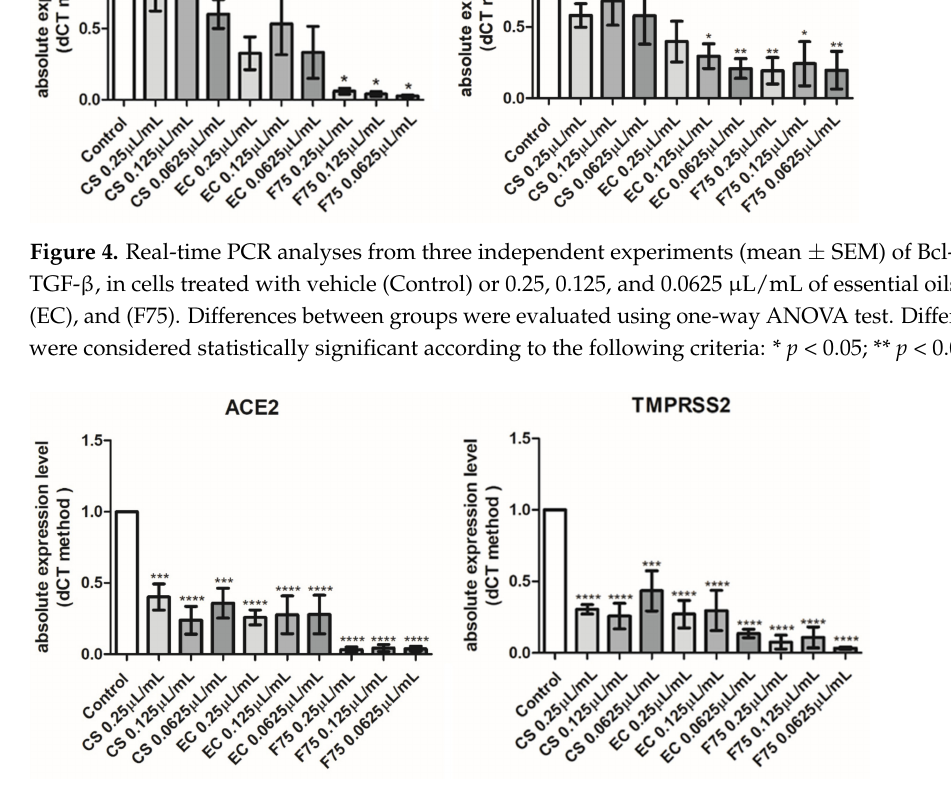
Figure 5. Real-time PCR analyses from five independent experiments (mean ± SEM) of ACE2 and TMPRSS2, in cells treated with vehicle (Control) or 0.25, 0.125, 0.0625 µ L/mL of essential oils (CS), (EC), and (F75). Differences between groups were evaluated using one-way ANOVA test. Differences were